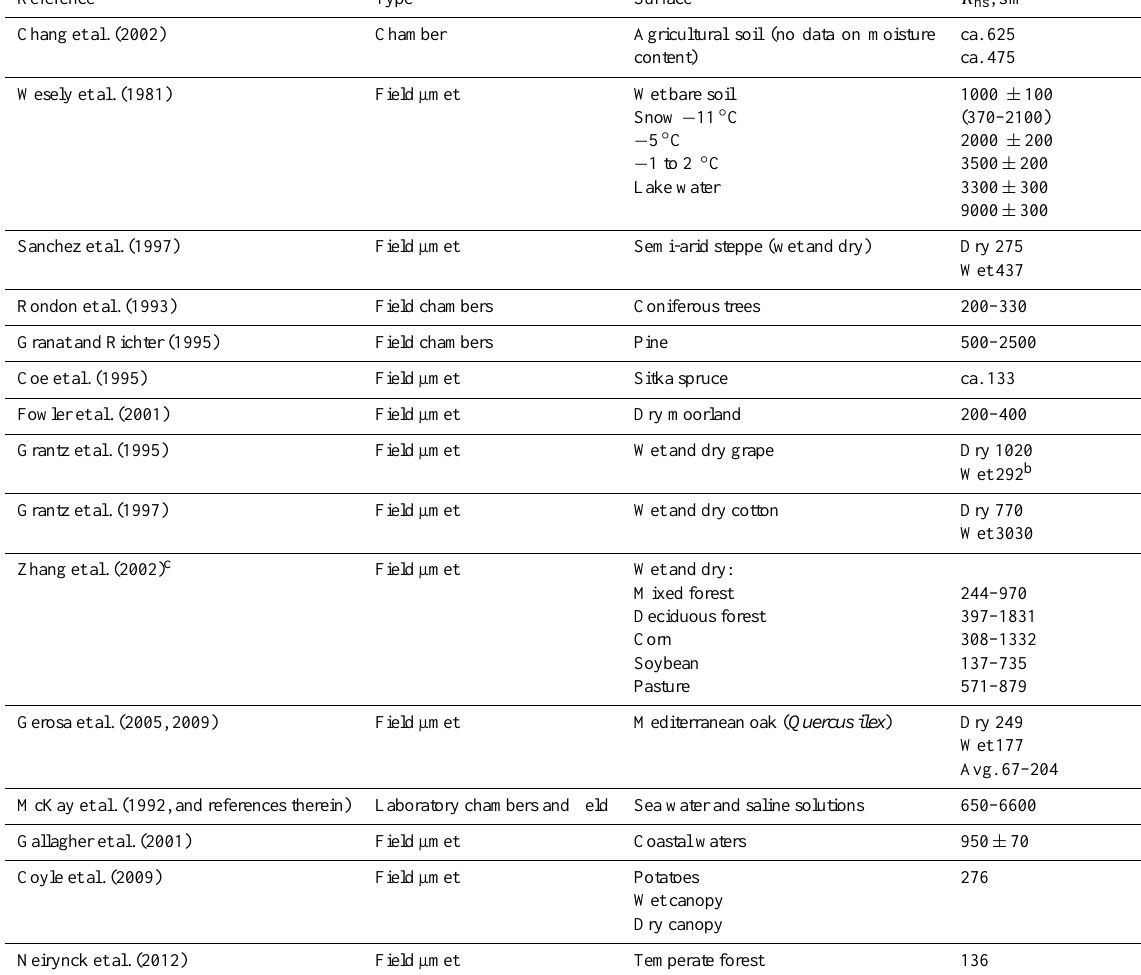
Table 1. Selected estimates of the non-stomatal resistance for ozone to snow, water, soil and plant surfaces from